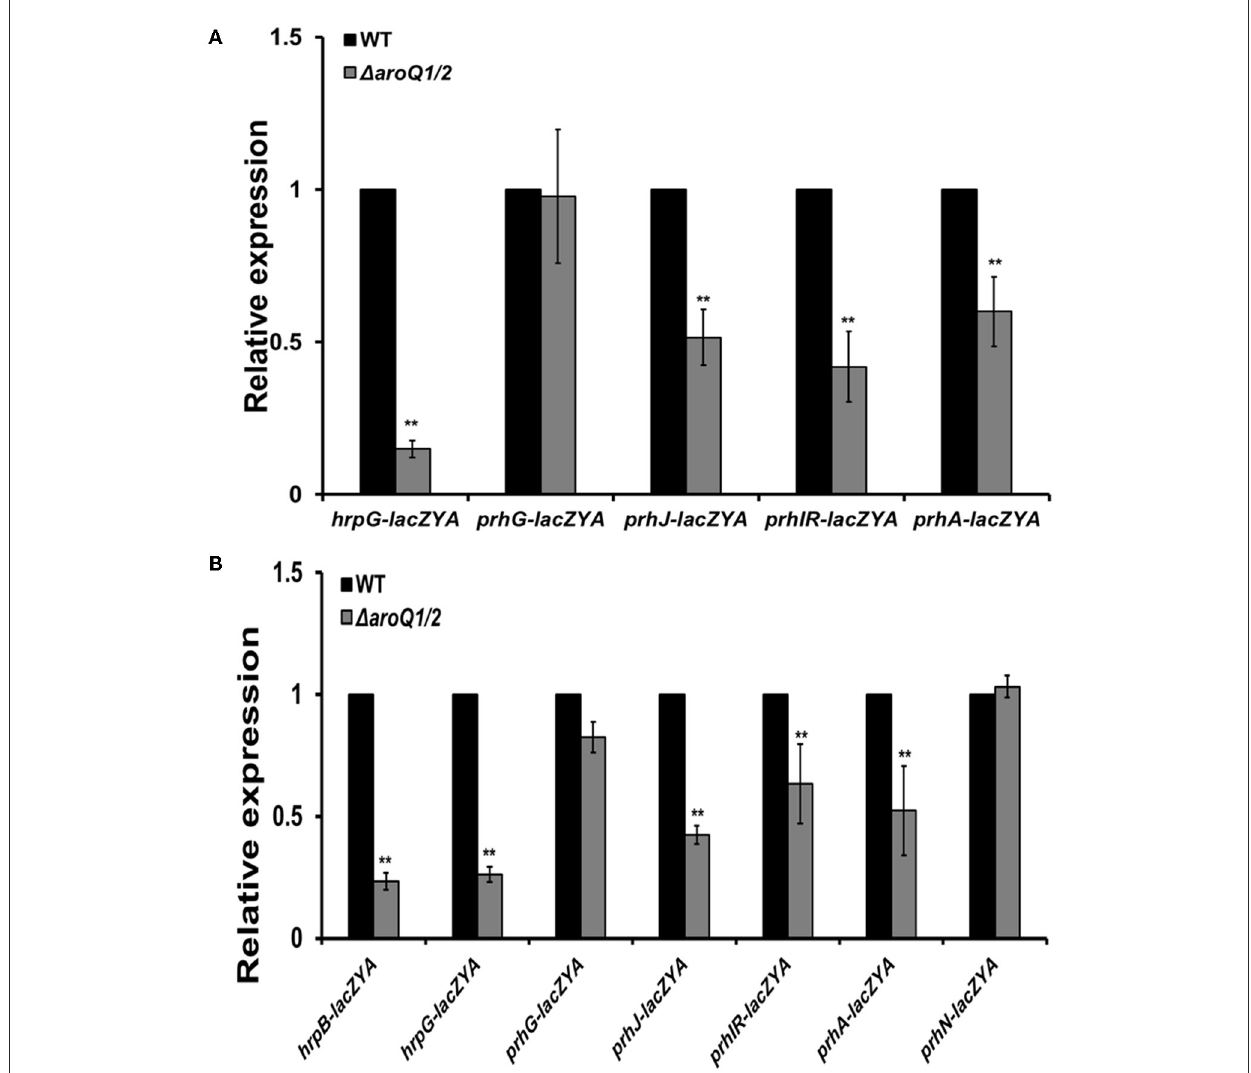
FIGURE4 Involvement of AroQ in the expression of T3SS-regulated genes in (A) nutrient-rich broth medium and (B) in the hrp -inducing minimal medium with supplementary SA at 300 µ M. WT refers to reporter strains of RK5046 ( hrpB-lacZAY ), RK5120 ( hrpG-lacZAY ), RK5212 ( prhG-lacZAY ), RK5619 ( prhN-lacZAY ), RQ6144 ( prhIR-laczYA ), RQ6074 ( prhJ-lacZYA ), and RK5134 ( prhA-lacZAY ). 1 aroQ/12 refers to the deletion of both aroQ1 and aroQ2 from each reporter strain. The hrpB expression was presented only in (B) hrp -inducing minimal medium since the expression of hrpB and the T3SS genes is not activated in a nutrient-rich broth medium. Enzymatic activities were assessed with the in vitro enzyme assay and presented in Miller units. Each assay was repeated with three biological replicates including three replicates per trial. Mean values of all experiments were averaged with SD and presented with relative expression compared with their parent reporter strains. Statistical significance between parent strains and the double mutant was assessed using a post-hoc Dunnett’s test following ANOVA. Significance level, ** indicates P < 0.01.